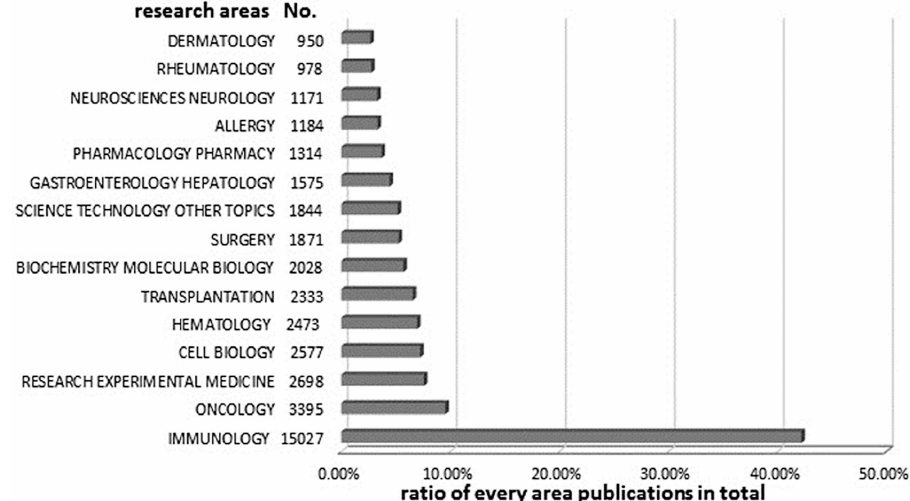
Fig 8. The 15 mostfrequentlyappearingresearch areas in regulatoryT cell (Treg) studies from 2000 to